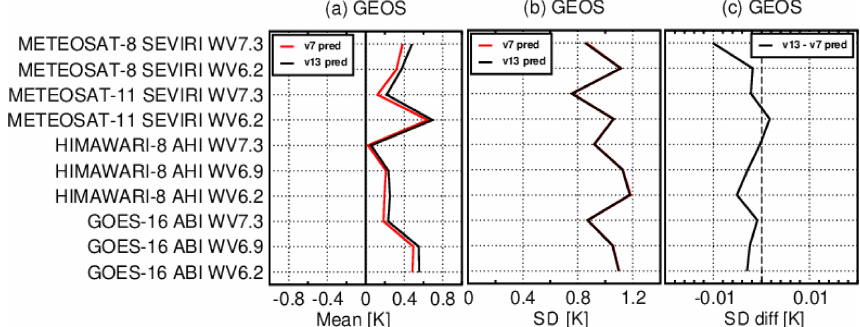
Figure 13. Global statistics of observation minus background (O − B) departure before variational bias correction for geostationary radi- ances during 1–31 March 2020 in the ECMWF system: (a) mean (O − B); (b) standard deviation of (O − B); (c) difference of the standard deviations; statistics for the v13 predictors with the variable O 3 experiment are shown in black, whereas statistics for the v7 predictors with the variable O 3 experiment are shown in red.